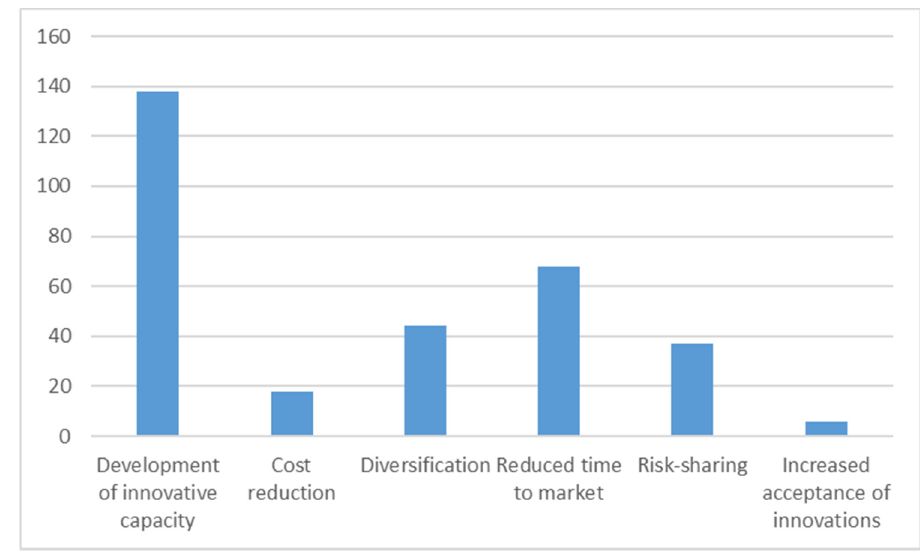
Figure 2. Benefits of open innovation for Portuguese SMEs.